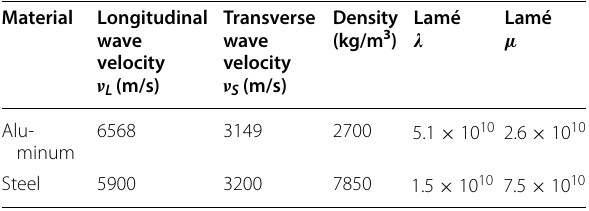
Table 1 Material properties of the simulation model Material Longitudinal wave velocity ν L (m/s)